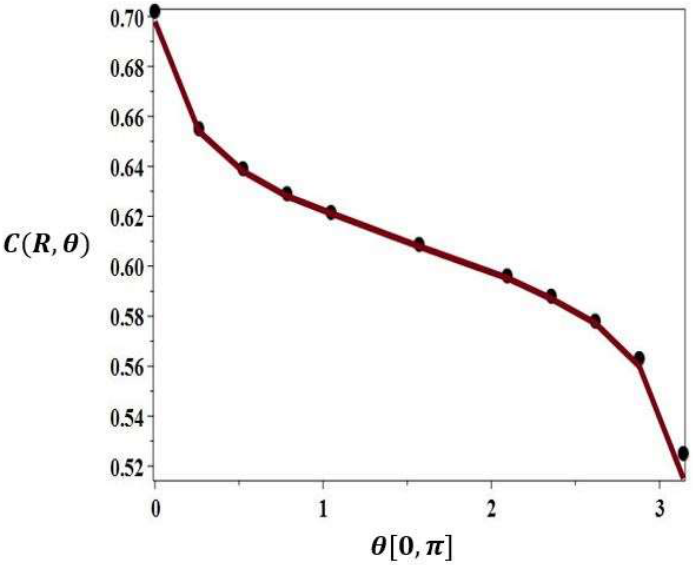
Figure 5. C (r = R , θ ) versus θ for Ra = 12.6, Le = 100, Ψ = 0.21 and R = 2 1/16 obtained analytically Figure 5. C ( 𝑟 = 𝑅, 𝜃 ) versus 𝜃 for Ra = 12.6, Le = 100, 𝛹 = 0.21 and R = 2 1/16 obtained analytically (continuous line) and using numerical direct simulation (black (continuous line) and using numerical direct simulation (black dots).